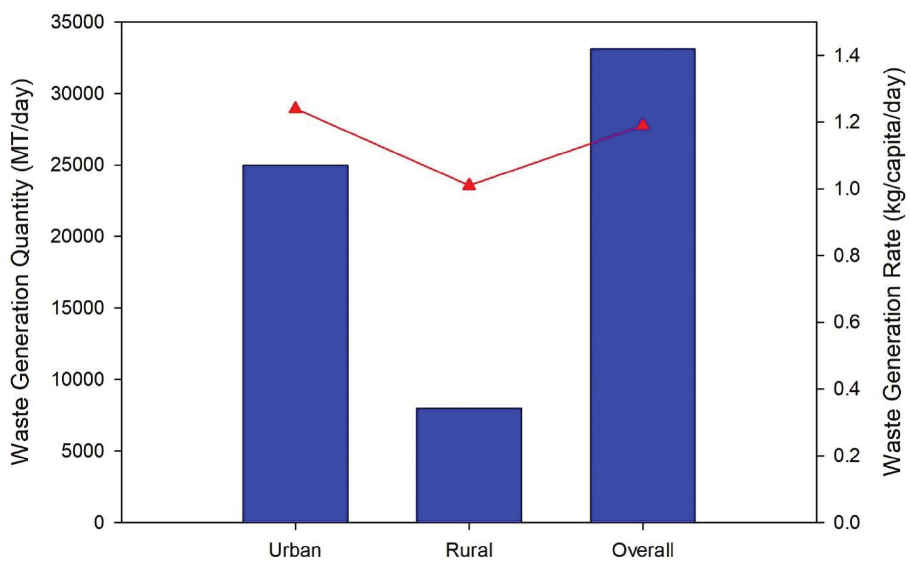
Fig. 1. Overview of waste generation from urban, rural, and overall areas in Malaysia (September 2011 to September 2012)